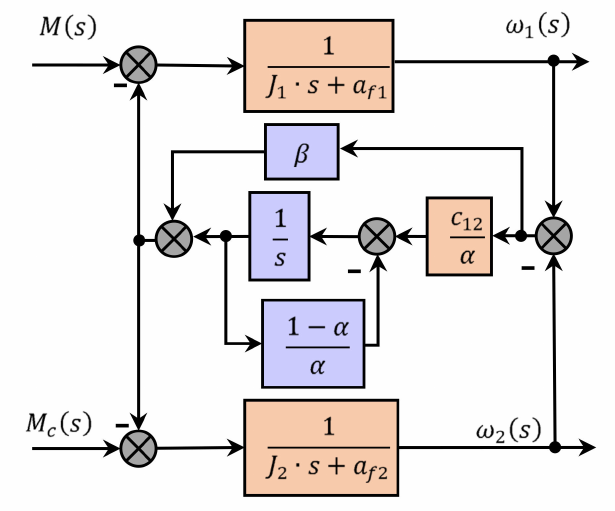
Figure 8. Block diagram of a two-mass system model when using a fractional integral to describe the elastic